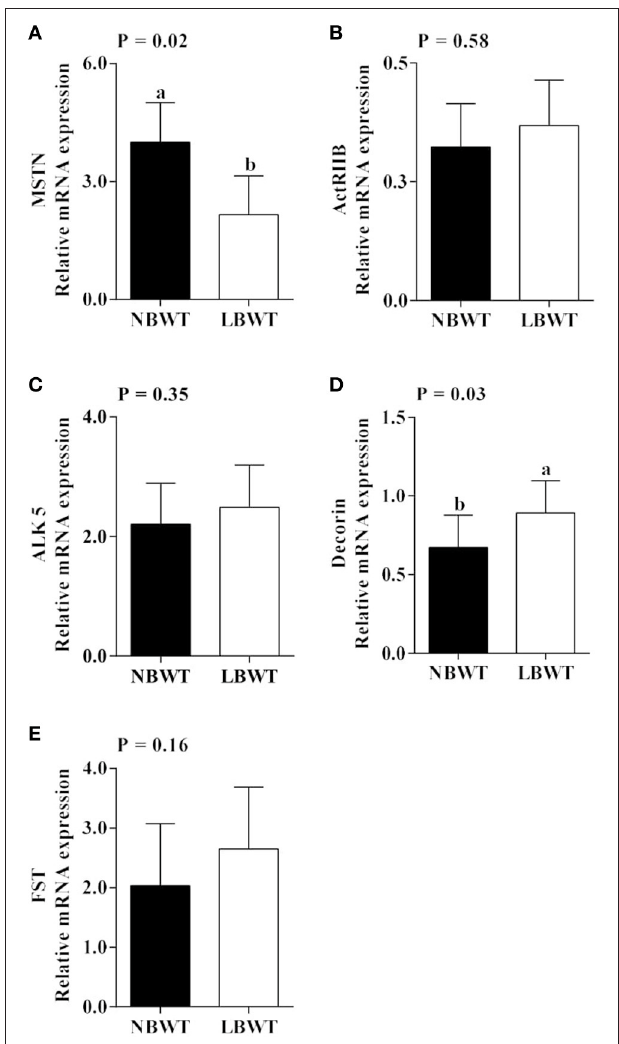
FIGURE 9 | Gene expression of myostatin (MSTN) system in longissimus dorsi skeletal muscle from low-birth-weight (LBWT) and normal-birth-weight (NBWT) neonatal pigs. (A – E) : Relative mRNA expression of MSTN, MSTN receptors, decorin, and follistatin (FST) . Results are means ± SE. n = 12. Values with different letters differ significantly ( P ≤